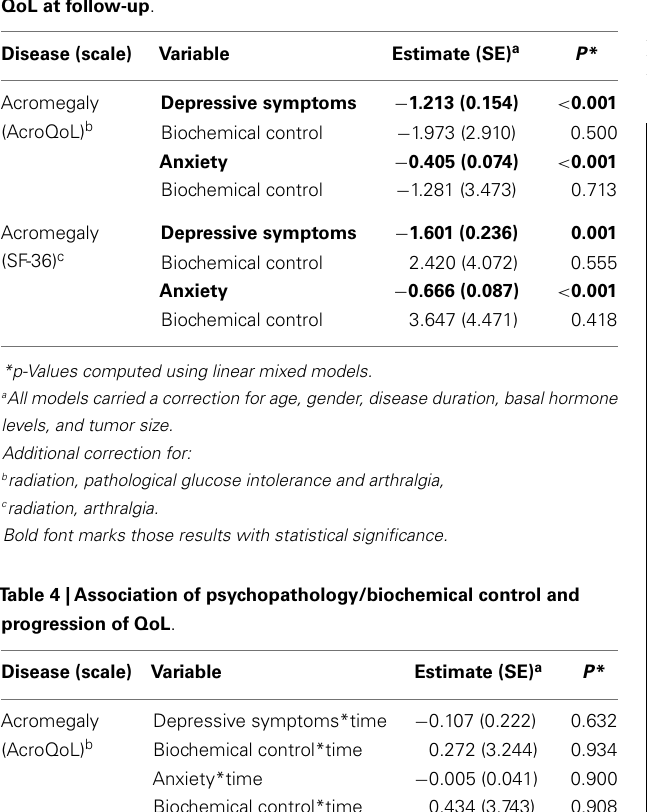
Table 3 |Association of psychopathology/biochemical control and QoL at follow-up .